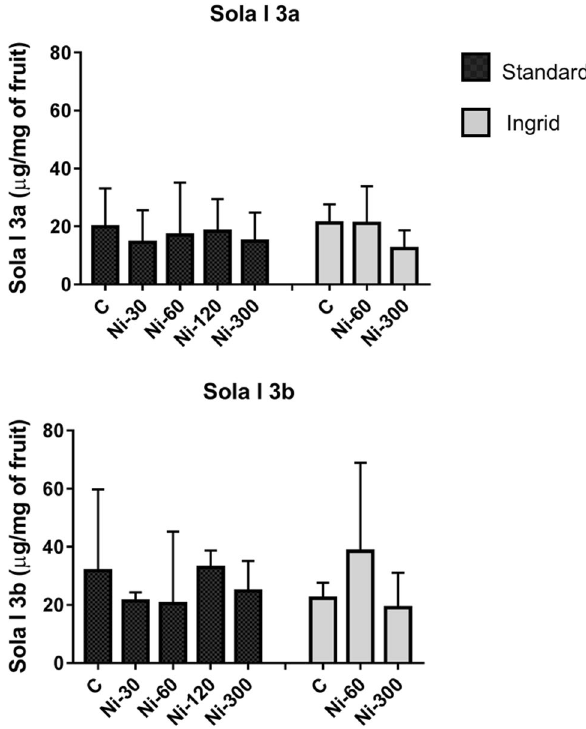
Figure 5. Concentration of Sola 3a and Sola l 3b in tomato samples. Black and grey bars indicate the cultivars ‘Standard’ and ‘Ingrid’, respectively. Values are reported as mean with range from quadruplicate or triplicate measures. Only the value of ‘Ingrid’ cultivar Ni-60 derives from a